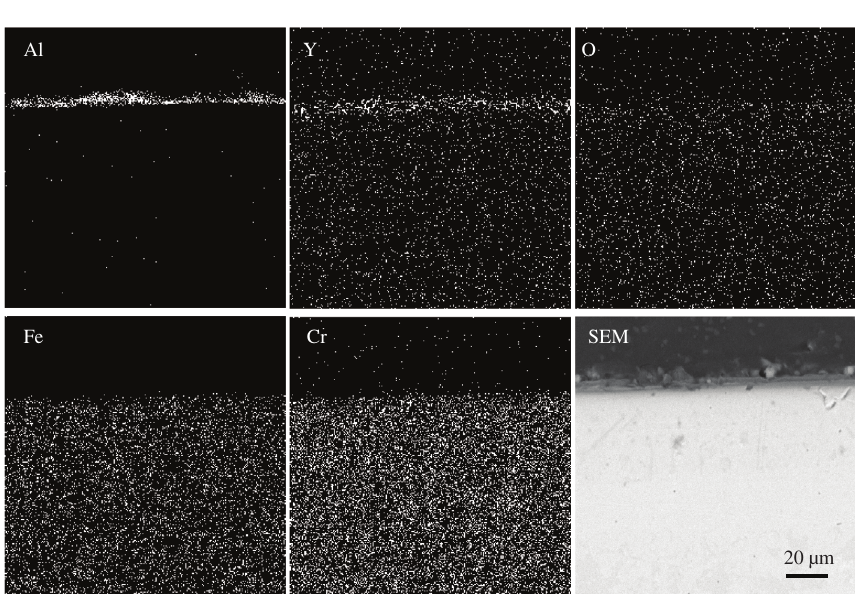
Figure 3: EDX pattern and cross-sectional morphology of the diffusion-annealed AlY